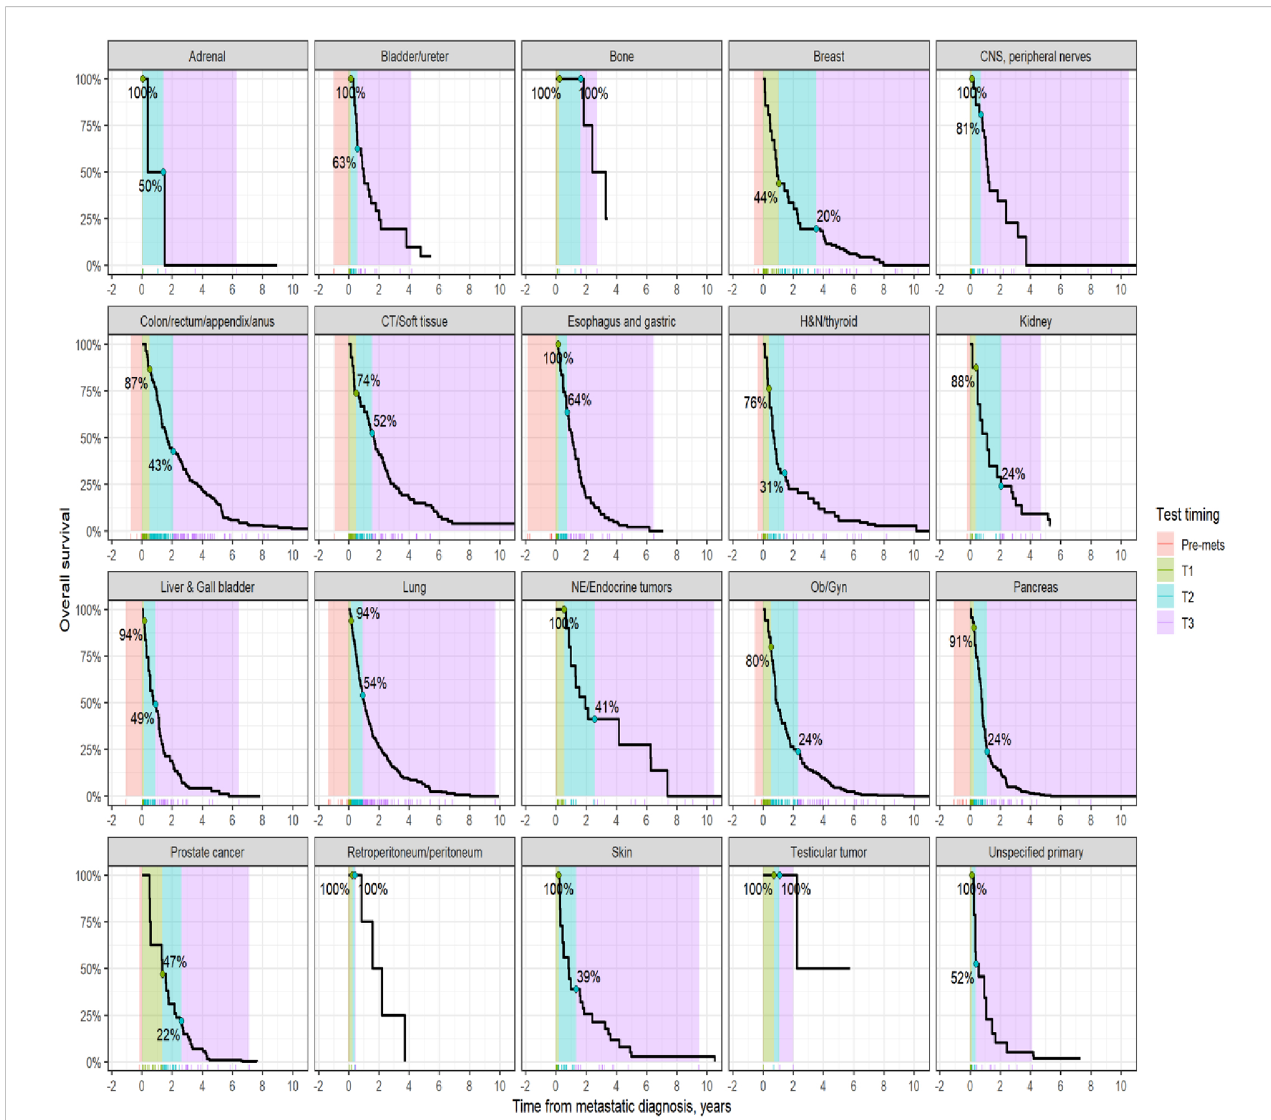
FIGURE 4 Kaplan-Meier estimates of overall survival by diagnosis. The shaded areas correspond to the diagnosis-speci fi c groupings of time to CGP test, with the colored tick-marks at the bottom showing the actual CGP test times. The unshaded areas are outside the observed range of CGP test times. The two labeled points show the estimated survival at the time when 1/3 rd and 2/3 rd of post-met CGP tests have